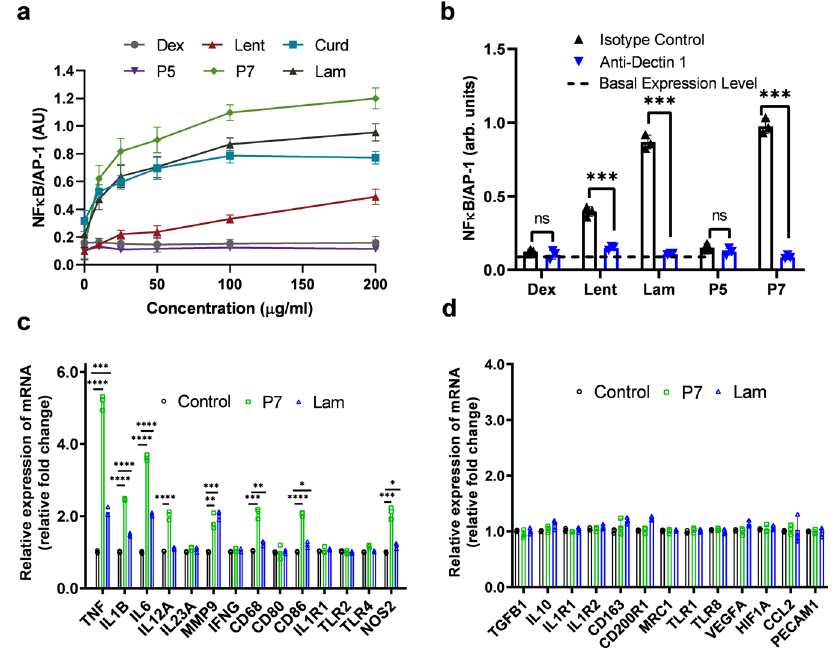
Fig. 6 | Activation of NF- κ B pathway in RAW-Blue cells and macrophage polarization in THP-1 cells. a Dose-dependent NF- κ B/AP-1 response elicited by PASs polymers, β -glucans, and dextran: 37°C, 24h. ( N =2 independent experi- ments, n =2 per condition). b Effect of anti-Dectin-1 blocking antibody, or